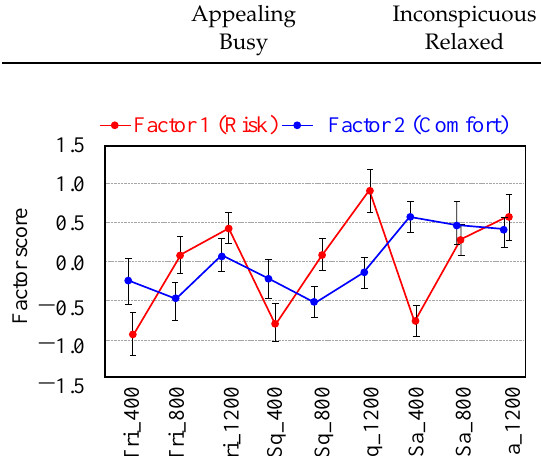
Figure 6. Average profile ratings obtained by the semantic differential (SD) test for ( a ) 400 Hz, ( b ) 800 Hz, and ( c ) 1200 Hz.